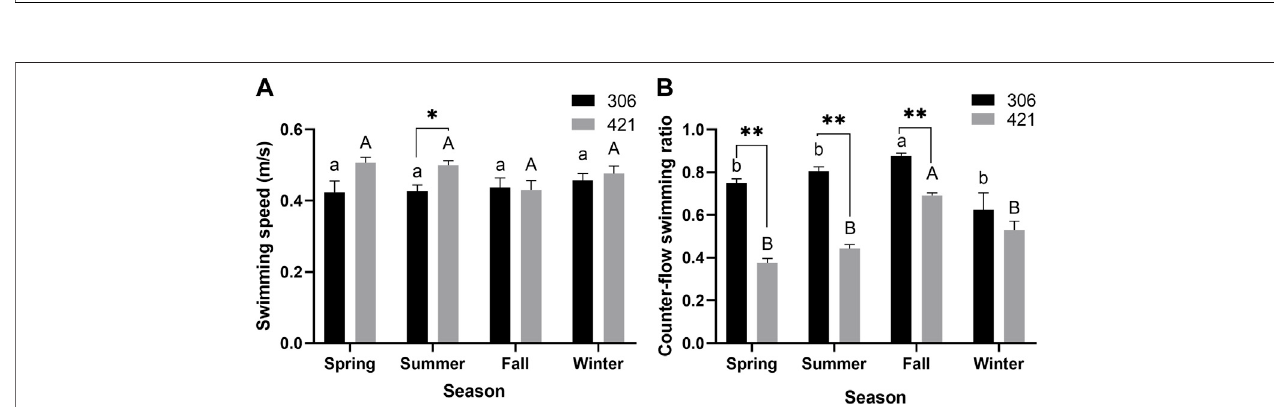
FIGURE 2 | Seasonal changes of (A) swimming speed and (B) counter- fl ow swimming ratio of two Chinese sturgeons during the study period. Seasonal data are mean ± SEM ( n = 3), the seasonal data of sample size ( n = 3) represents the three monthly data within one season. Signi fi cant difference ( p < 0.05) and highly signi fi cant difference( p < 0.01)betweenthemaleandfemaleindividualsinthesameseasonaredenotedbyoneandtwoasterisks,respectively.Differentuppercaselettersindicate statistically signi fi cant differences among different seasons in the male Chinese sturgeon ( p < 0.05), whereas different lowercase letters indicate statistically signi fi cant differences among different seasons in the female Chinese sturgeon ( p < 0.05).